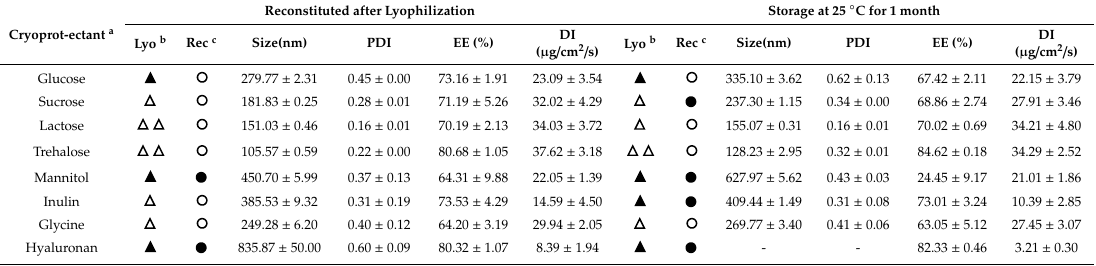
a: the concentration of cryoprotectants was fixed at 8%, b: lyophilized appearance, non-caked, critically shrunken, sprayed, or loose, slightly shrunken, caked and compact, c: reconstituted appearance, aggregated, translucent. “-” means the data could not be obtained because the reconstituted samples were aggregated.